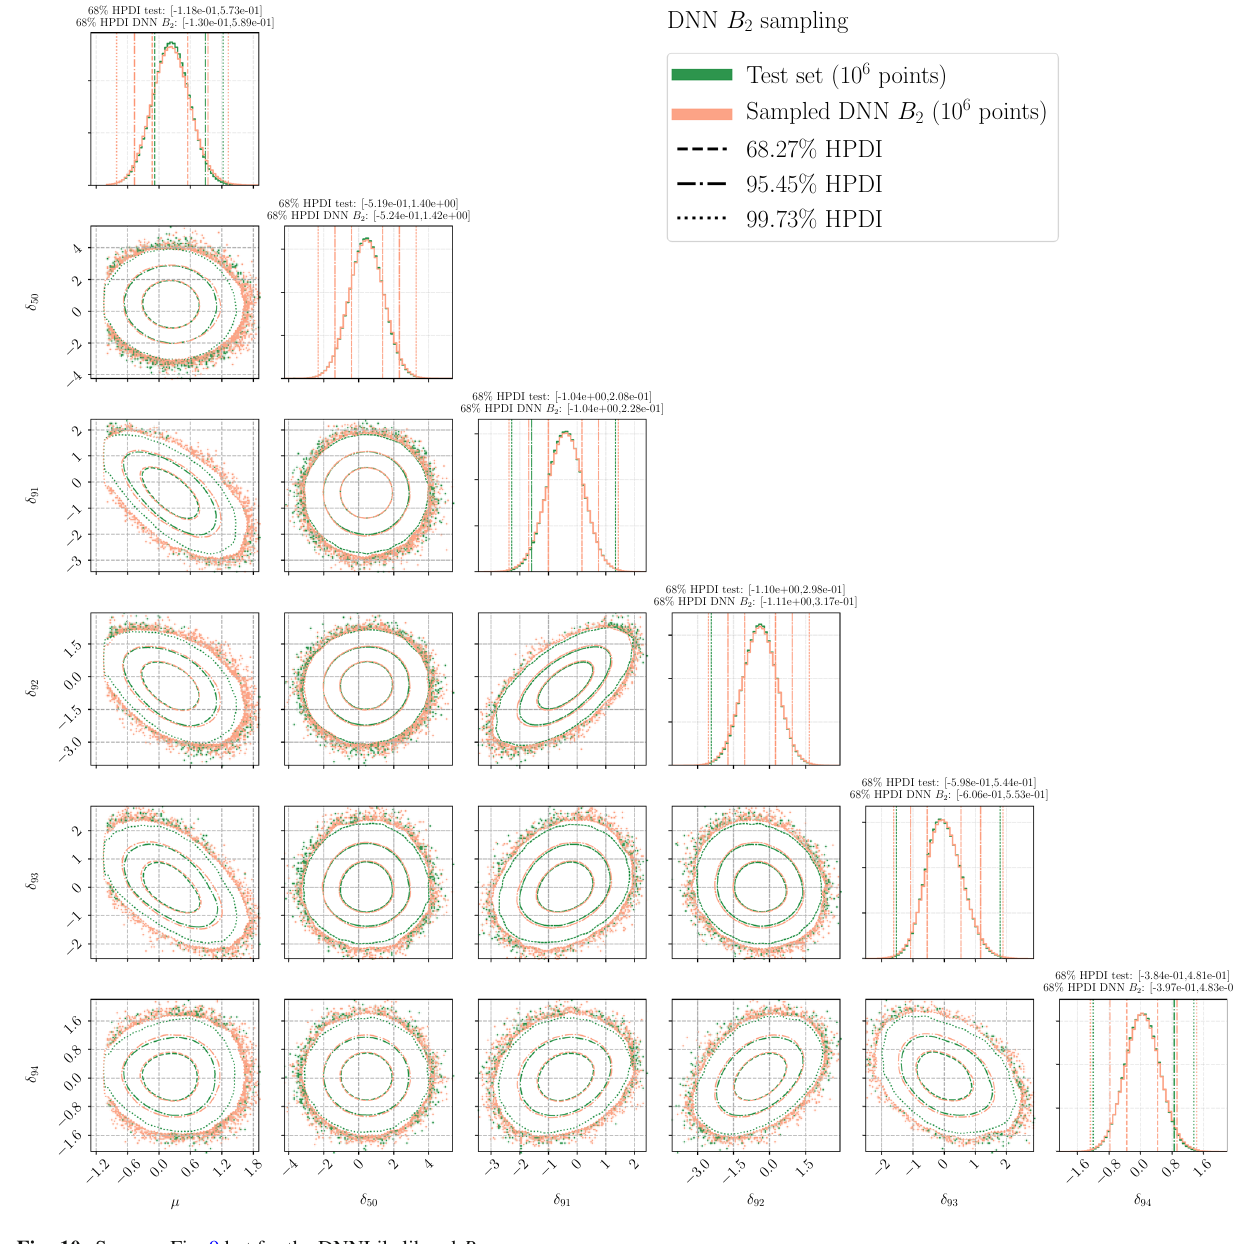
Fig. 10 Same as Fig. 9 but for the DNNLikelihood B 2 models B 1 − B 3 already satisfactory, and do not go beyond 5 × 10 5 training